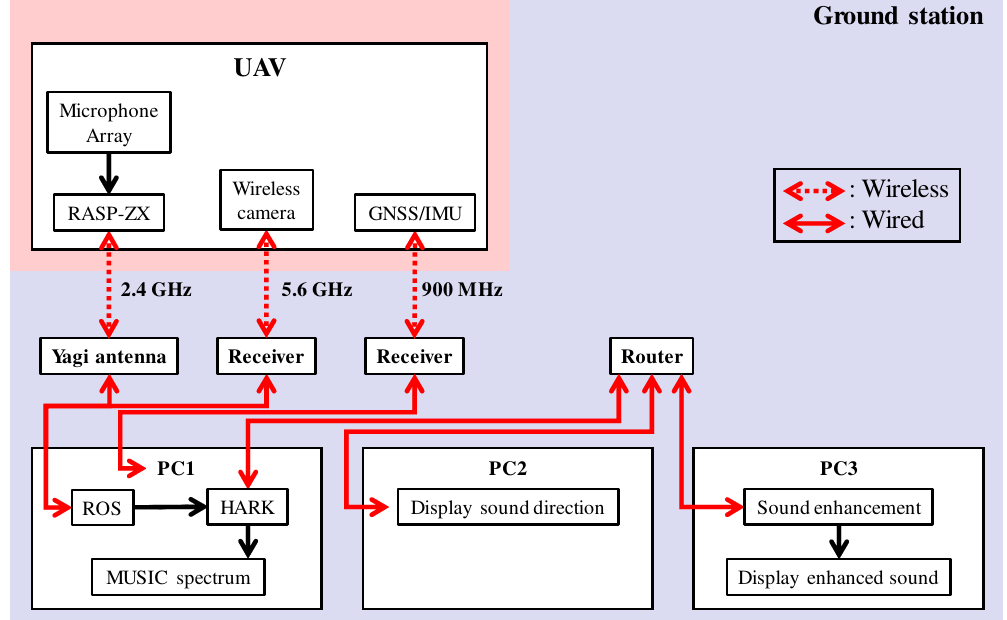
Figure 9. Configuration of